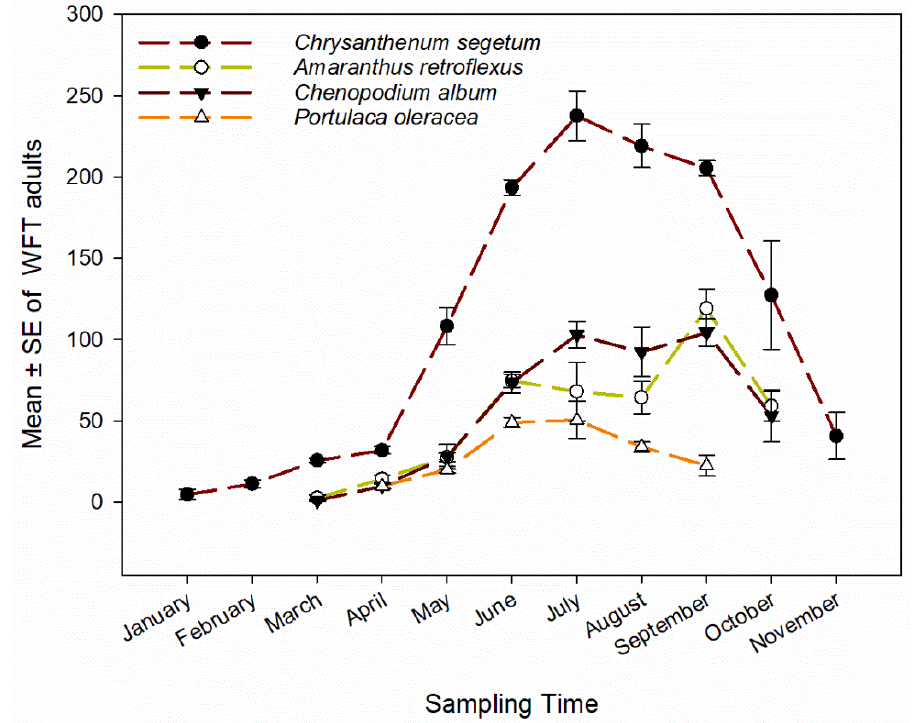
Figure 6. Seasonal density of WFT on wild herbaceous plant species.